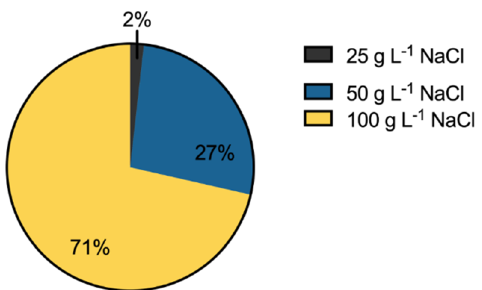
Figure 4. Percent distribution of isolates by levels of salinity tolerance, defined as the maximum concentration of salt (g L − 1 NaCl) for which growth was observed.